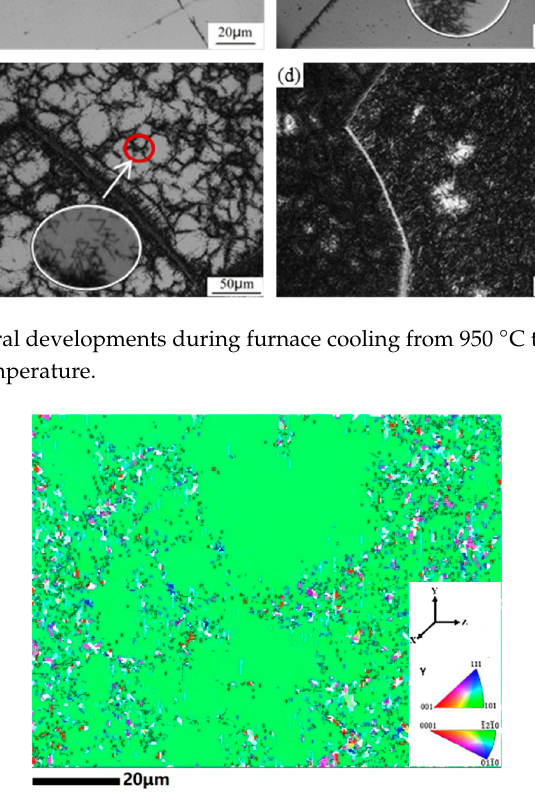
Figure 6. Inverse pole figure (IPF) map of the network structure.